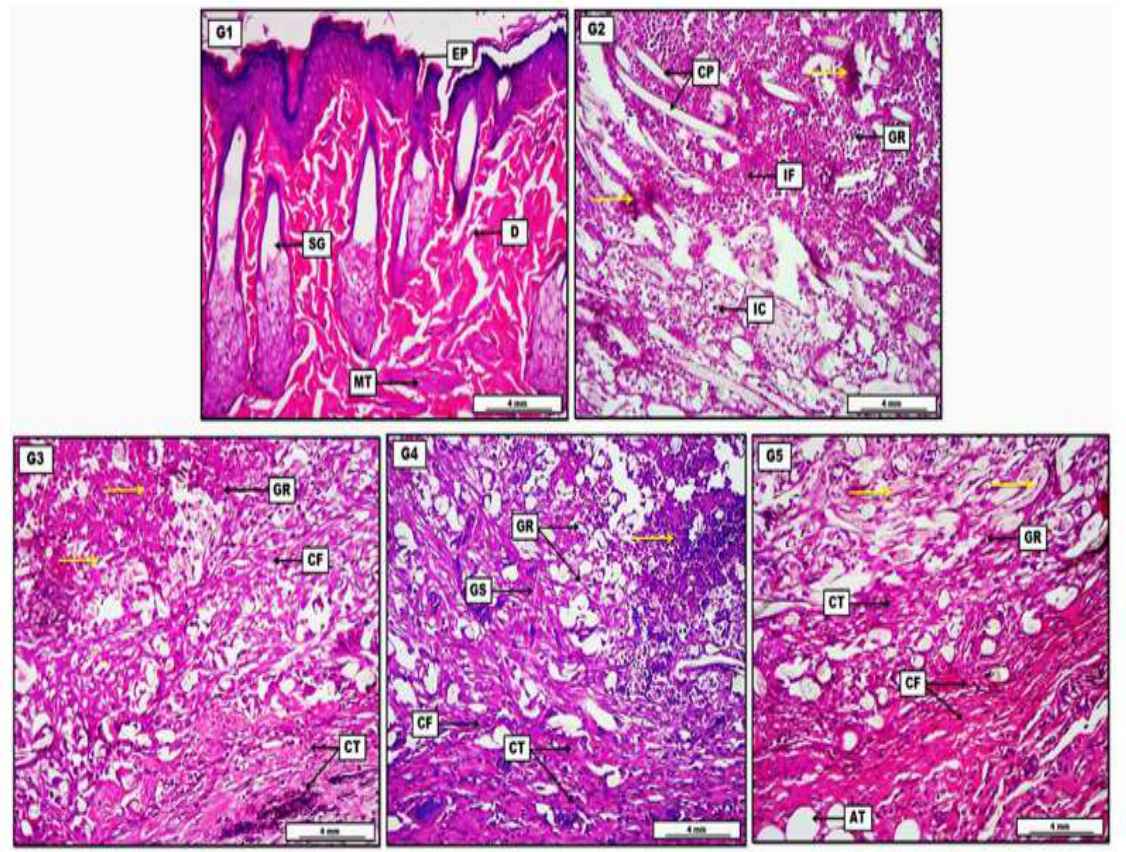
Figure 5.Photomicrograph of skin from groups; (G1) Control group, show distinctive structural arrangement of the epidermis (EP) and dermis (D), with the presence of several sebaceous glands (SG) attached to hair follicles together with some muscle tissue (MT) seen in the skin section. (G2) Granuloma positive group, demonstrate the area of granuloma (GR) infiltrated with significant amount of inflammatory exudate (IF) mixed with inflammatory cells (IC), together with the presence of several longitudinal sections of cotton pellets (CP). Slight deposition of calcium crystals within the granuloma area (yellow arrows) indicates local tissue destruction. (G3) Granuloma with Ginkgo biloba (GKB) 200mg/kg group, reveal significant reduction in the area of granuloma (GR) together with the number of inflammatory cells and exudate (yellow arrows). Granuloma area is replaced with deposition of eosinophilic connective tissue (CT) consisting of many proliferated collagen fibers (CF) and inflammatory cells. (G4) Granuloma with dexamethasone 1mg/kg group, show significant reducing in the amount of inflammatory exudate (yellow arrow), the granuloma area (GR) is contained by eosinophilic deposition of ground substance (GS) together with proliferated collagen (CF) and connective tissue (CT). (G5) Granuloma with prednisolone 5mg/kg group, show significant reduction of inflammatory exudate within the area of granuloma (GR), in addition to, deposition of connective tissue (CT) and proliferation of more collagen fibers (CF) which infiltrate the granuloma. Various sections of cotton pellet (yellow arrows) can be seen within the granuloma given section, along with some amount of adipose tissue (AT). H&E. Scale bars: 4